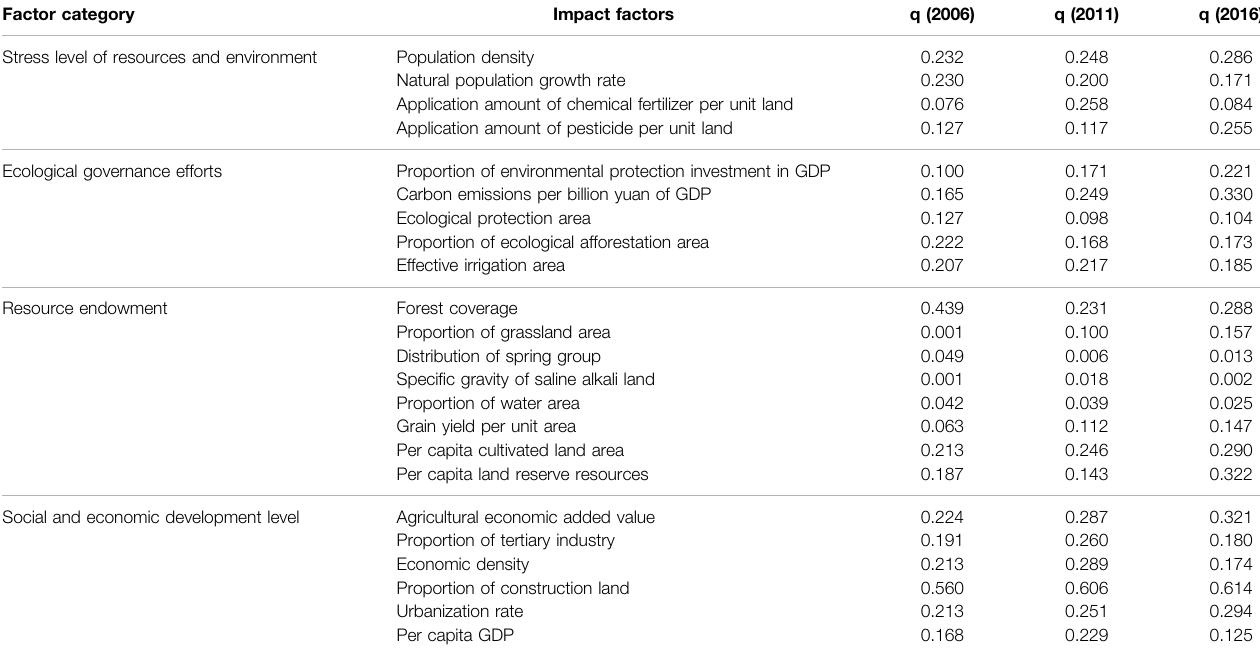
TABLE 4 | Geographical detector factors of land ecological security in Jinan from 2006 to 2016. Factor